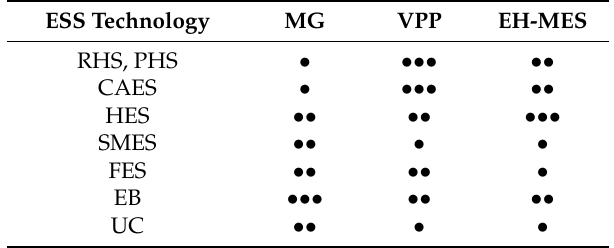
Table 4. Suitability of ESS technologies for different SDN